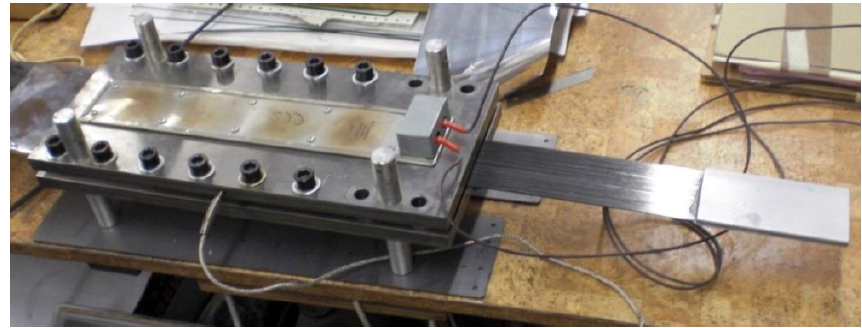
Figure 6. Curing of the adhesive bonding in a heating device.